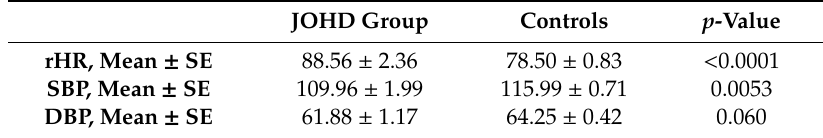
Table 2. Primary